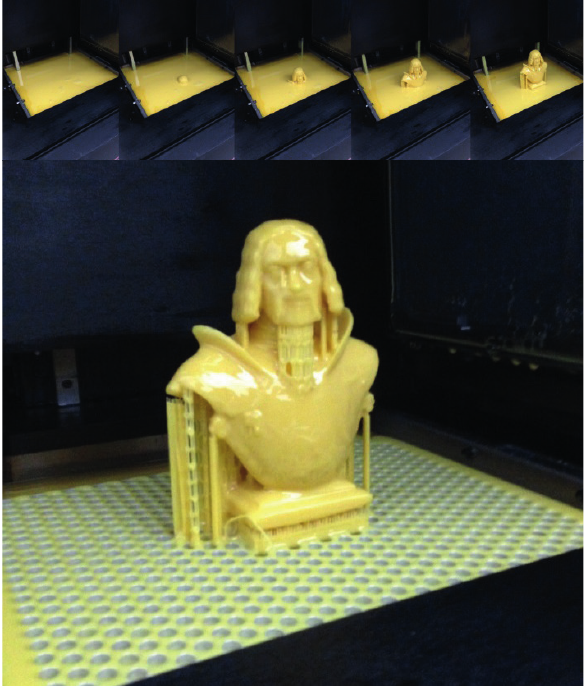
Figure 7: Above: different steps of the construction of the resin solid. Below: the 3D printed model on the plane of the printer, still with